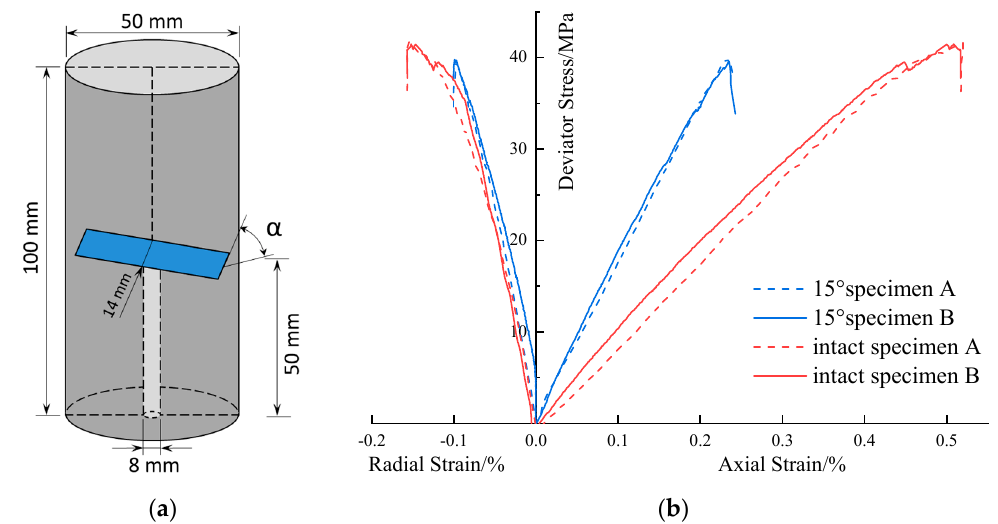
Figure 1. ( a ) Schematic diagram of the specimen; ( b ) stress–strain curves for consistency evaluation.